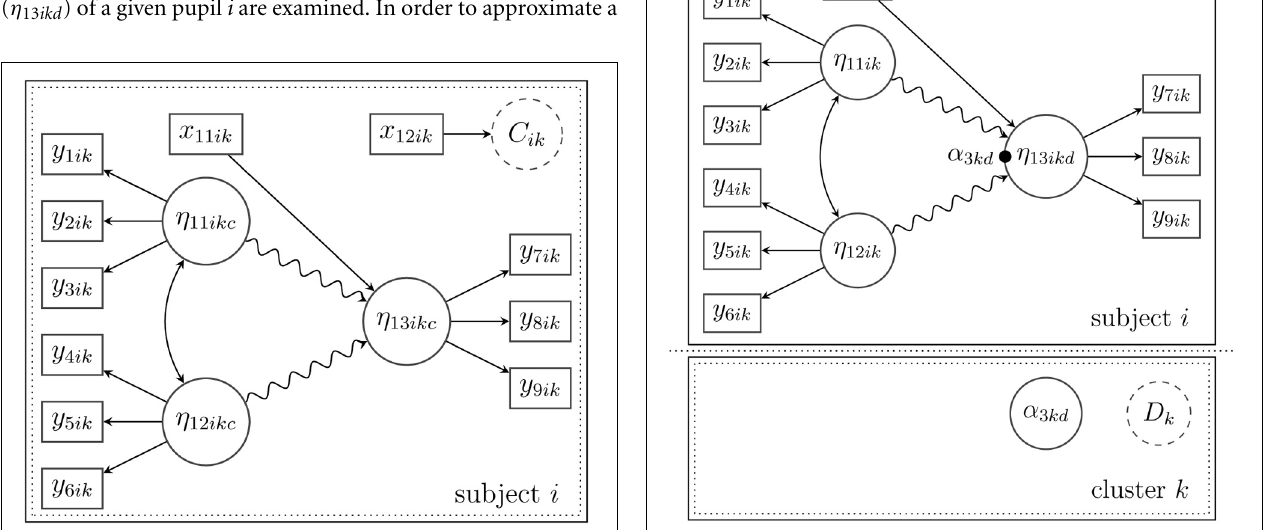
FIGURE 4 | Structural model for subject i in cluster k with a nonlinear spline relationship between the latent variables on the within-level (indicated by the snake-type arrow) and a random intercept ( α 3 kd ) that is modeled as a mixture of normal distributions on the